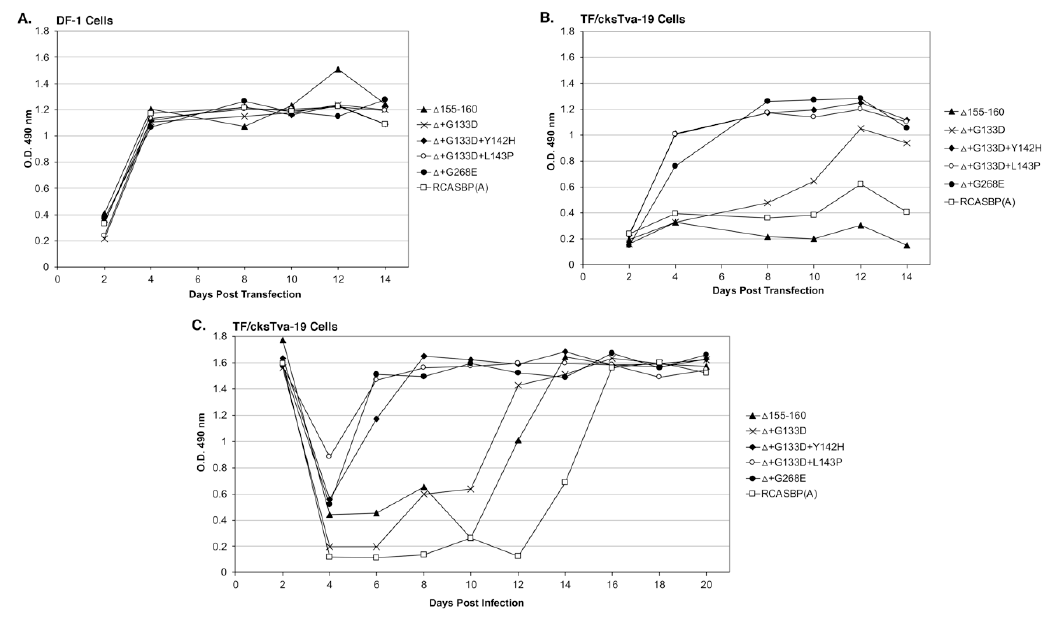
Figure 3. Virus replication rates of Δ 155–160 and the evolved Δ 155–160 mutant viruses. Viral